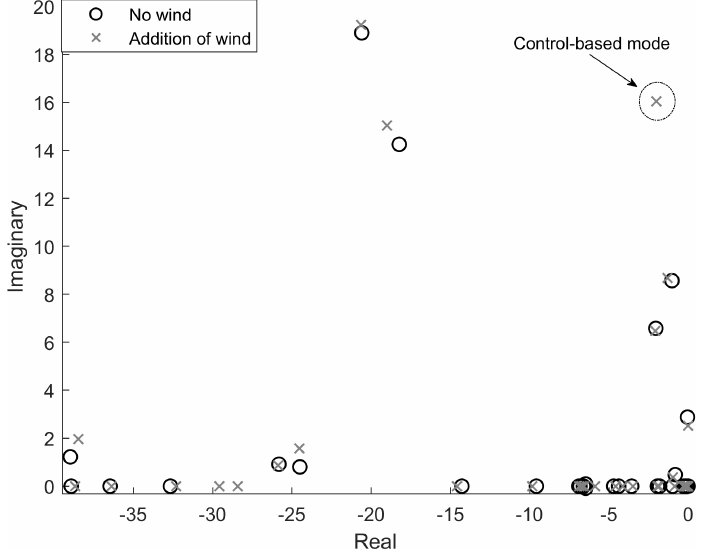
Figure 6. Comparison of eigenvalues between scenarios A and B.